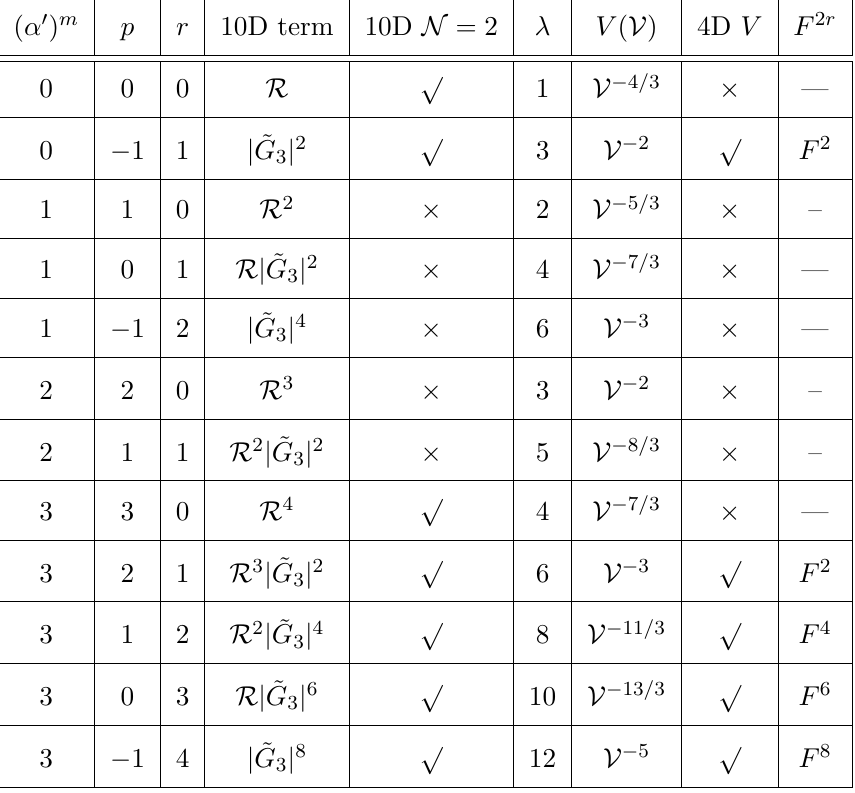
Table 1 . Volume scaling and F-term order of different α 0 corrections to the 4D scalar potential generated by various 10D terms. The V dependence and the number of inverse metric factors λ is obtained from (2.31) and (3.1). 10D terms of the form R p +1 ( ∇ ˜ G ) 2 r can also be incorporated by 3 noticing that they would scale as R p + r +1 ˜ G 2 r 3